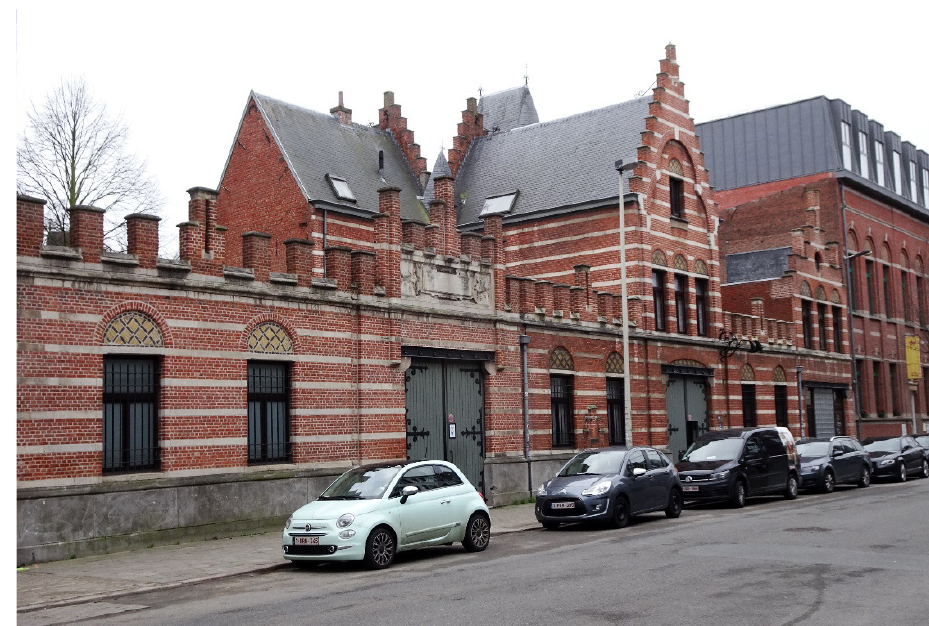
Figure 3. Herring Smoking Factory. Source: Photo by Peter Vermeulen, 2022, Creative Commons.